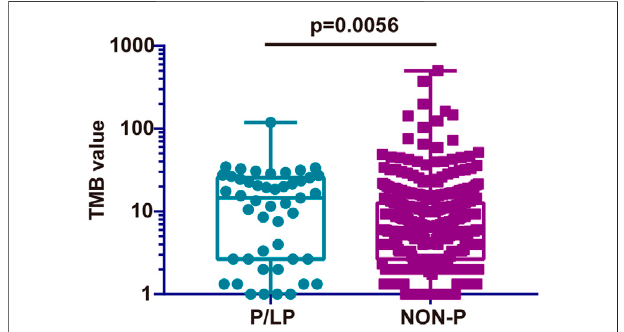
regulatory Tregs ( p (cid:1) 0.0291) and Myeloid dendritic cell resting ( p (cid:1) 0.0163) were lower in the DDR group ( Figure 8A ). However, no association was observed between the different DDR pathway alterations and immune cell abundance ( Figure 8B ).